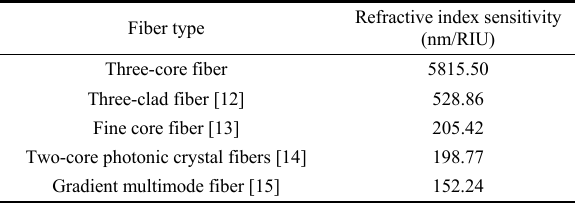
Table 2 Sensor refractive index sensitivity using different types of